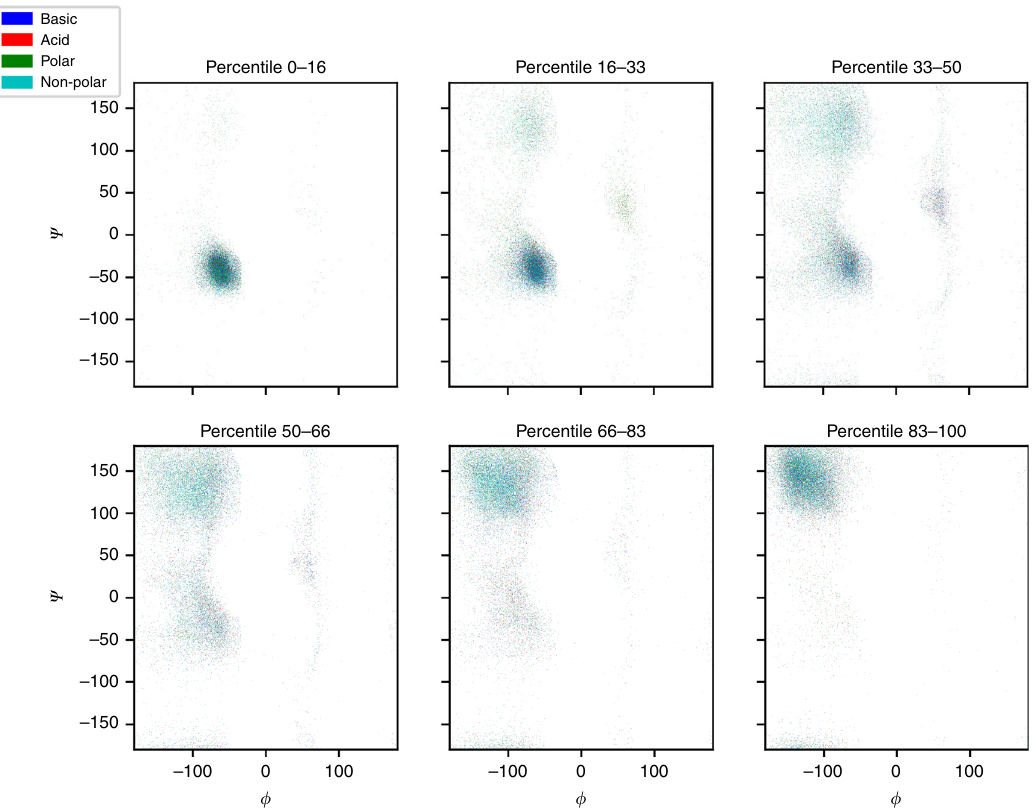
Fig. 1 Relation between the torsion angles and the Shiftcrypt index. Every plot represents an interval of the ShiftCrypt index. The amino acid types are de fi ned by color: blue for basic, red for acid, green for polar, and cyan for